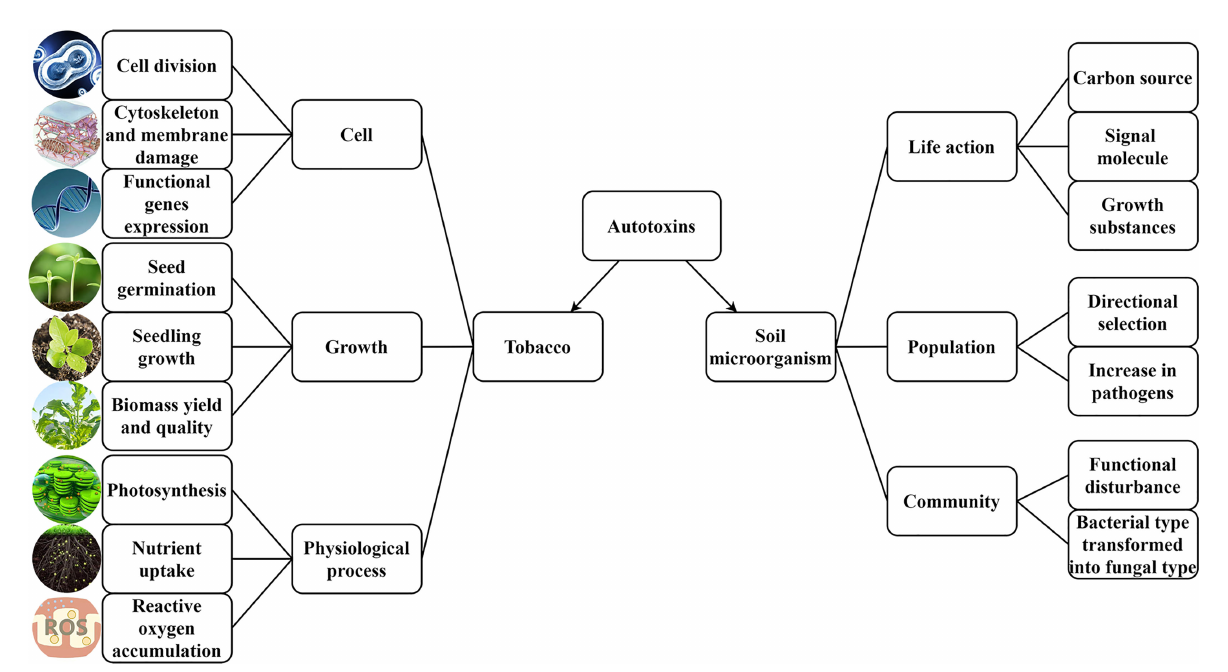
FIGURE 1 Effects of autotoxins on tobacco and soil microorganisms. Autotoxins affect tobacco at three levels of cell, growth, and physiological processes and affect soil microorganisms at three levels of life action, population, and